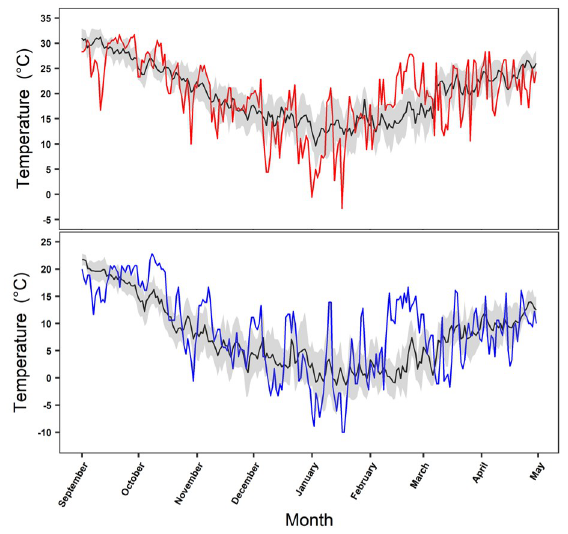
Fig 5. Comparison of air temperatures during the year of our study and the ten-year average. Mean ten-year (2007–2016) daily high (top panel) and low (bottom panel) temperatures from 01 September through 30 April for Lee County, AL (black line, top and bottom panel) and daily high (red line, top panel) and low (blue line, bottom panel) temperatures for this location during the year of our study (2017–2018). Gray band represents the 95% confidence for the ten-year average in both panels. Climate data retrieved from the National Oceanic and Atmospheric Administration (NOAA; https://www.ncdc.noaa.gov/cdo-web/datatools/selectlocation) in January 2020 from a weather stations in Lee County, Alabama (Station